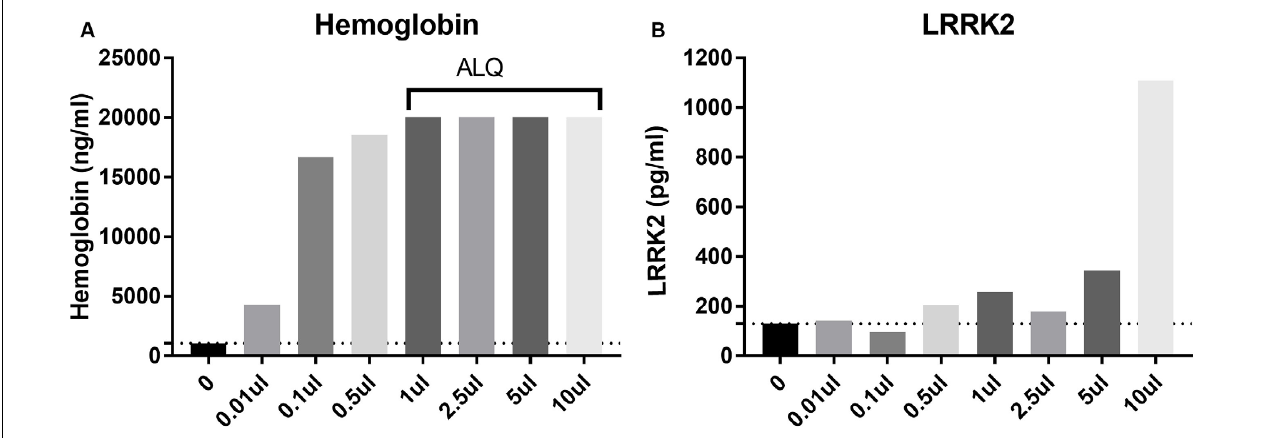
FIGURE 4 | Spiking in whole blood into CSF dramatically increases measured hemoglobin levels (A) with all samples more than 1 ul (0.01% v/v whole blood spiked in) having levels above the limit of quantification (ALQ) of the assay. LRRK2 levels in those same samples did not increase significantly until 5 µ l of whole blood was spiked into 1 ml [i.e. when blood made up 0.5% of the entire sample by volume; (B)